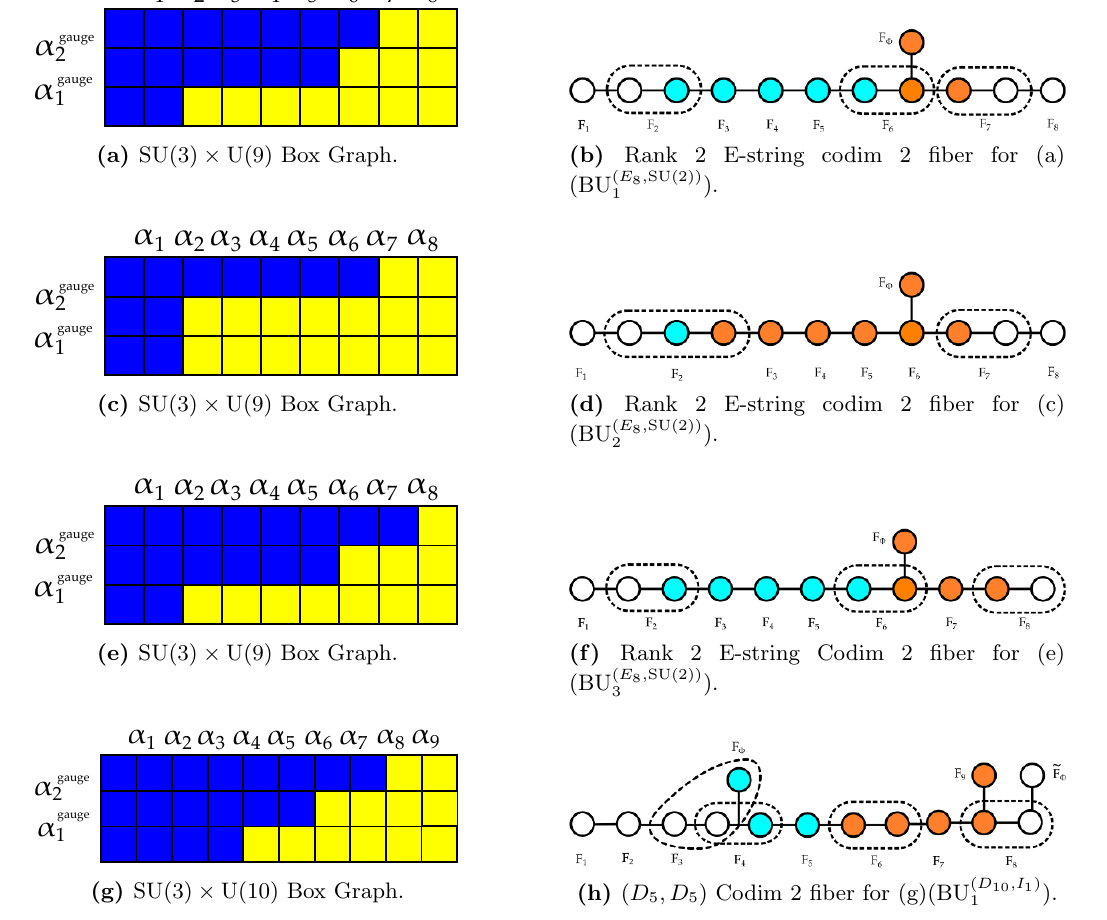
Figure 27. Examples, (a) to (f), of box graphs and the associated codimension two (cid:12)bers for SU(3) gauge (cid:2) U(9) BG phases of the rank two E-string, as well as one example, (g) and (h), for ( D 5 ; D 5 ) conformal matter; these examples have appeared in Part I, [2], in terms of explicit resolutions.